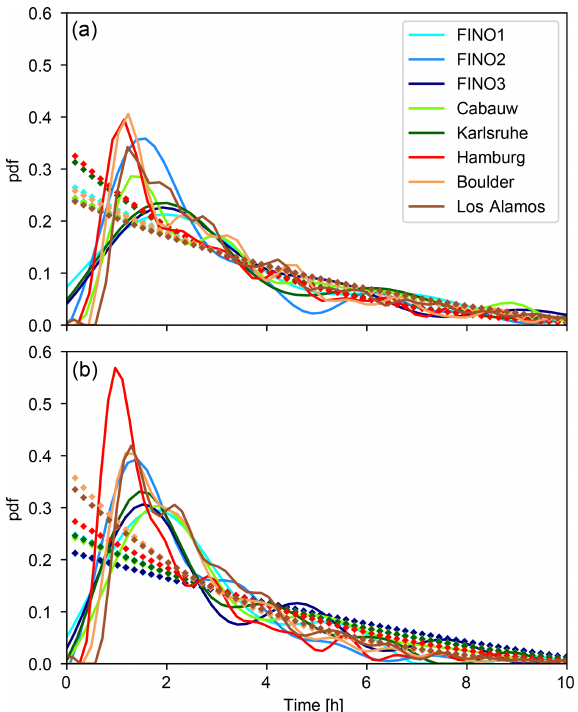
Figure 4. Probability density functions of the vSBL (a) and wSBL event durations (b) as estimated from the VP ref (solid lines) at the different tower sites compared to FSMC pdfs computed using Q ref and a nighttime duration of 12h (diamonds). All pdfs are calculated with the multivariate kernel density estimation by O’Brien et al. (2014,